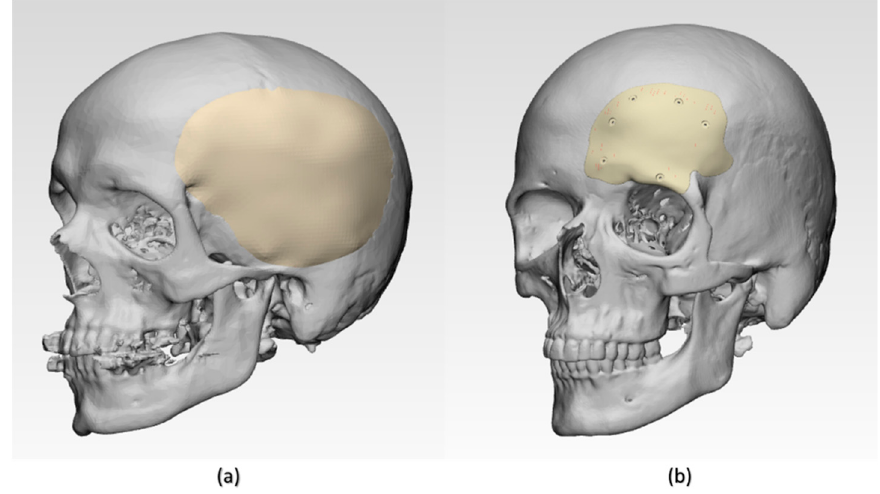
Figure 3. Illustration of three-dimensional (3D) volumetric reconstructions of craniofacial structures with patient-specific implants (PSIs). ( a ) Group 1 class III cranial defect reconstruction with PSI and ( b ) Group 2 class IV cranial defect reconstruction with PSI.